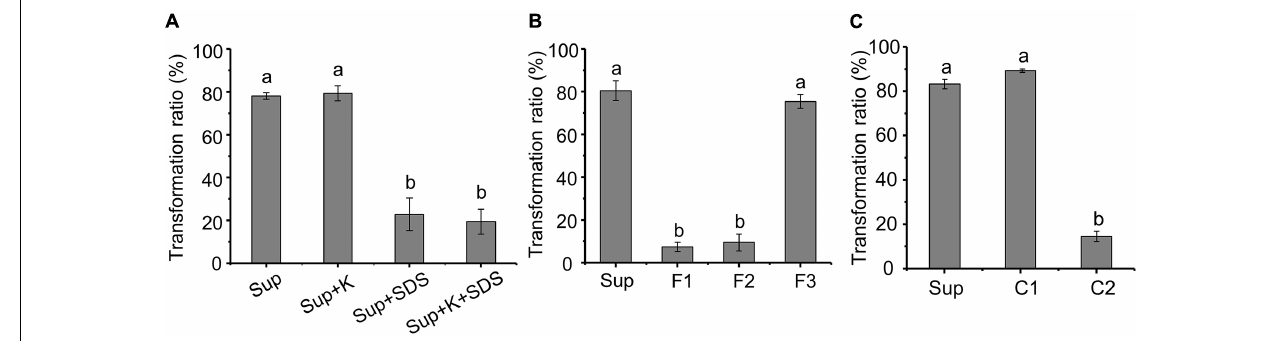
FIGURE 5 | Preliminary analysis of the metabolite transforming aflatoxin B 1 (AFB 1 ). (A) Effect of protein K and SDS on AFB 1 transformation by supernatant. Sup: supernatant; Sup + K: proteinase K treated supernatant; Sup + SDS: SDS treated supernatant; Sup + K + SDS: proteinase K and SDS treated supernatant. (B) AFB 1 transformation by three fractions obtained from supernatant by ultrafiltration. F1, F2, and F3 correspond to samples > 3, 1–3, or < 1 kDa, respectively. (C) AFB